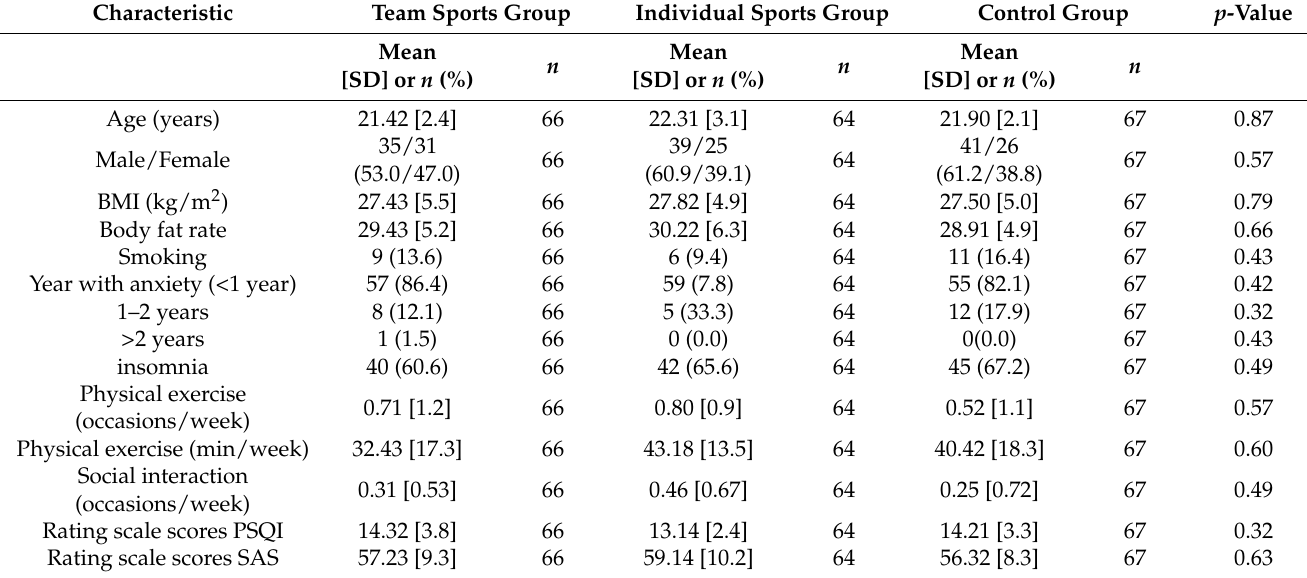
Table 1. The basic datasheet for the three groups.